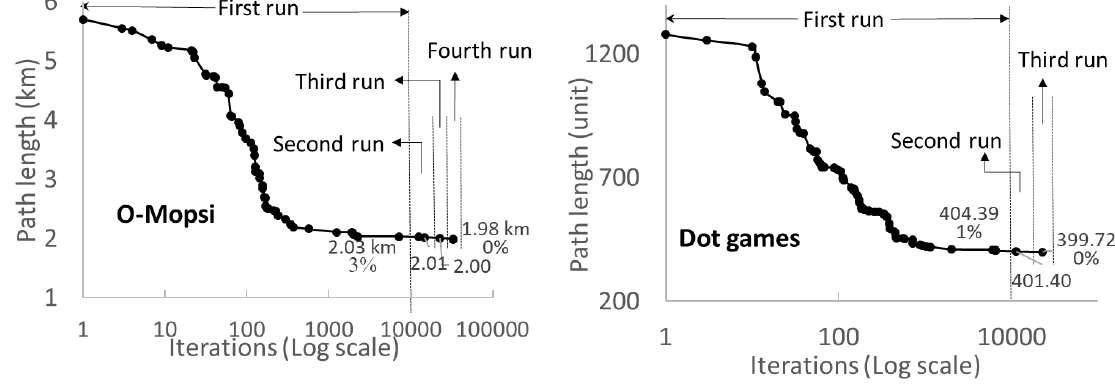
Figure 16. Typical example of the effect of repetition.